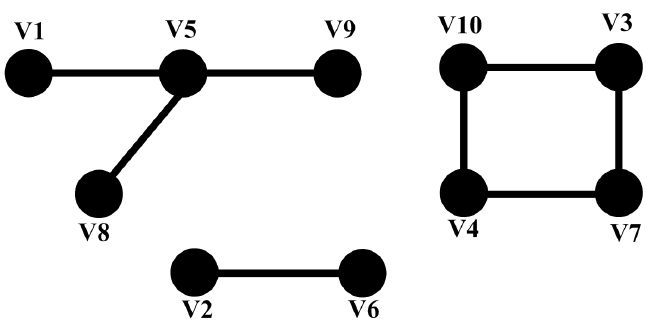
Figure 3. Flowchart of the proposed scheme to stabilize a system after islanding.